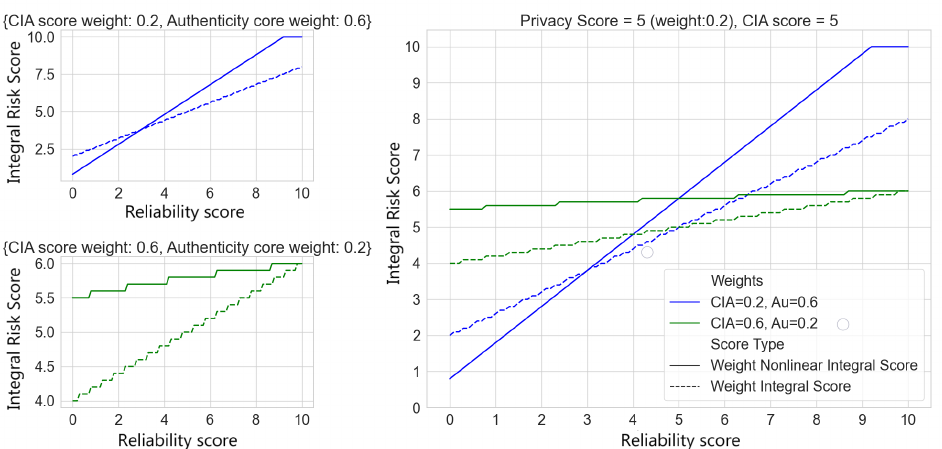
Figure 2. Impact of metric weights on the integral risk scores calculated using weighted sum function (weight integral score) and proposed nonlinear weight function (weight nonlinear integral